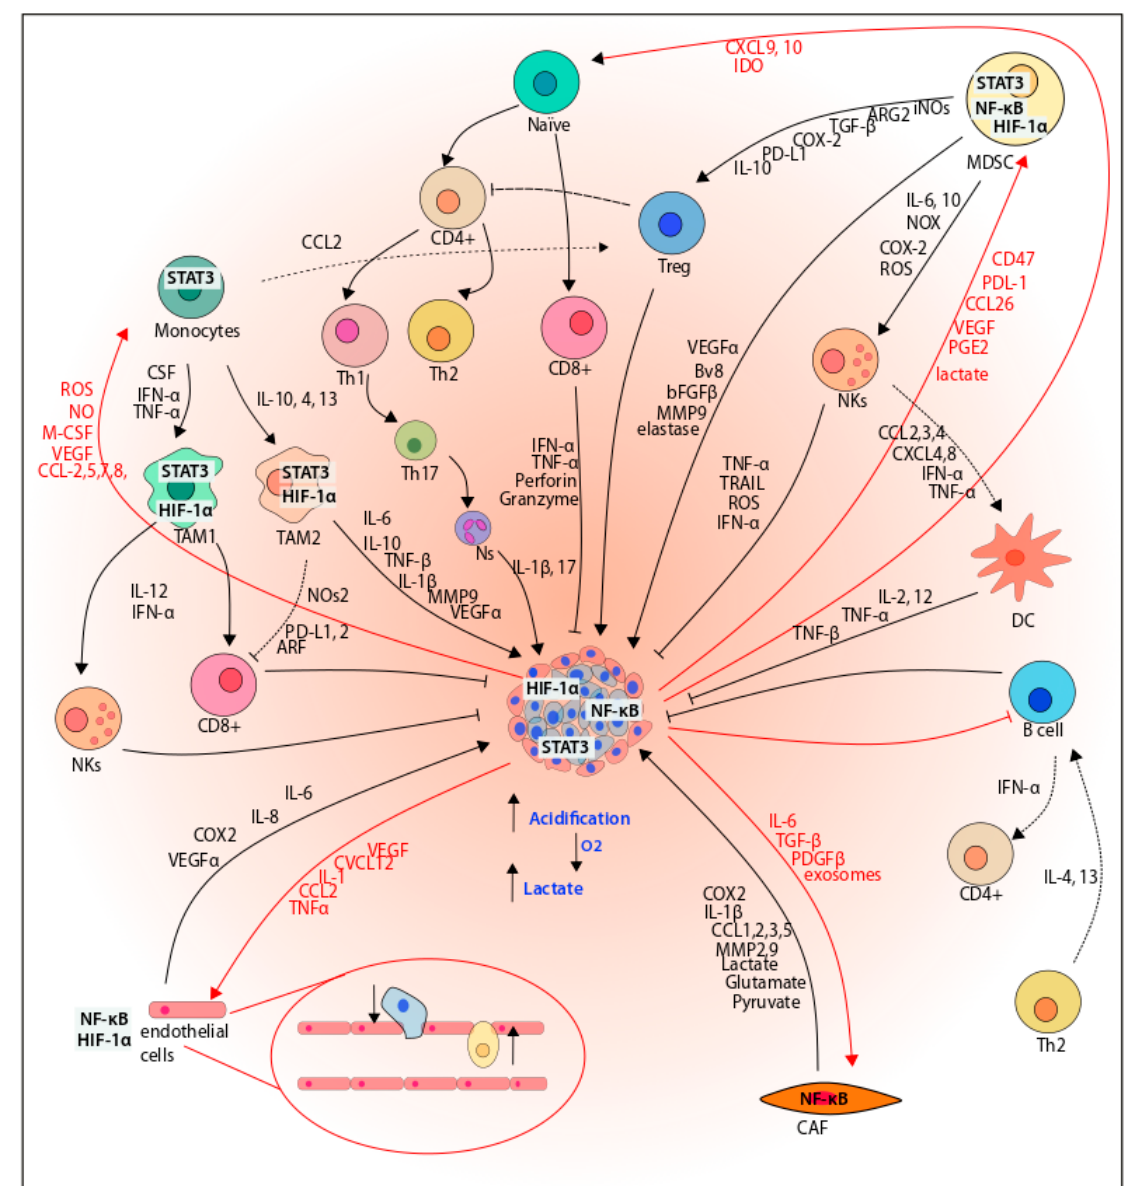
Figure 6. Intercommunication between tumoral and immune cells in hypoxia. Hypoxia triggers the activation of HIF-1 α , NF κ B, and STAT pathways, boosting the transcription and releasing of chemotactic factors (CXCL12, VEGF, and CCL-2, -5, -7, -8, -12 and -26), pro-inflammatory cytokines (TNF- α , TNF β , and IL-1,-6) as well as the secretion of exosomes, PD-L1, lactate, PGE2, ROS, and NO, among other molecules that targets immune cells. Red arrows represent the stimulation of immune cells, whereas red truncated arrows represent inhibition. These signal molecules activate several mechanisms that result in the infiltration of pro-tumor immune cells, such as TAMs, MDSCs, CAFs, Ns, and Treg cells, to the tumor, which suppress the anti-tumor response of CD8+ cells, B cells, NK cells, and dentric cells (DCs). Immune cells, in response, release IL-1 β , -4, -6, -8, -10, -12, -13, -17, CCL-1, -2, -3, -5, -22, TNF α , TNF- β , IFN- γ ,M- CSF, VEGF, bFGF β , PDGF, PDL1, MMP-2,-9, Arg-1, NOX2, and COX-2 as well as the release of glutamate, pyruvate, and lactate among other molecules, resulting in the promotion of inflammation, metabolic adaptations, growth of tumors, epithelial to mesenchymal transition, angiogenesis, migration, invasion, metastasis, and resistance to chemo, radio, and immune therapy. Black arrows represent the stimulation of tumoral cells, whereas black truncated arrows represent inhibition. See main text for more